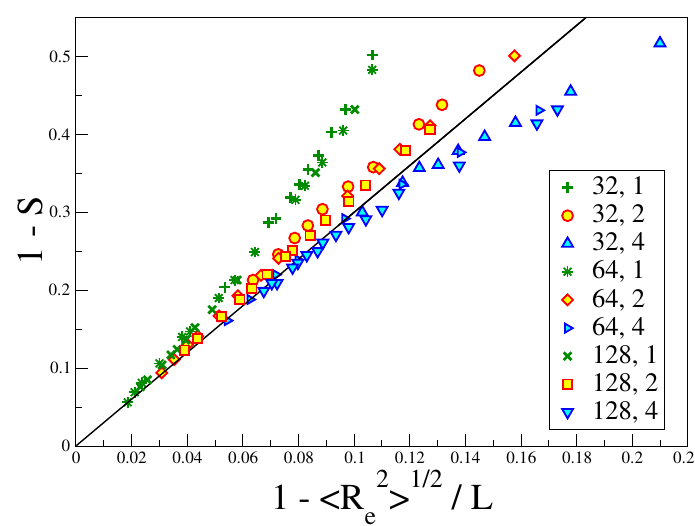
Figure 6. Plot of the order parameter reduction 1 − S versus the relative reduction of the end-to-end distance 1 − (cid:104) R 2 e (cid:105) 1/2 / L . Three choices of the chain length N ( N = 32, 64 and 128), and in each case, three choices of the parameter N / (cid:101) b = 1, 2 and 4 are included, as indicated in the key. The straight line indicates Equation (29). Reproduced from [43] with permission from the Royal Society of